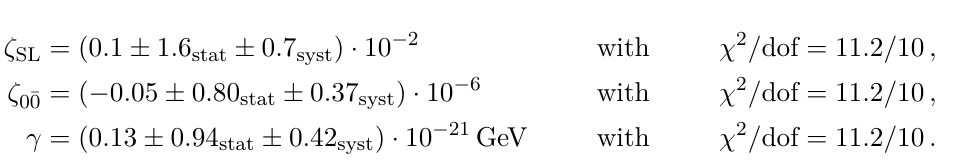
For the decoherence parameters ζ